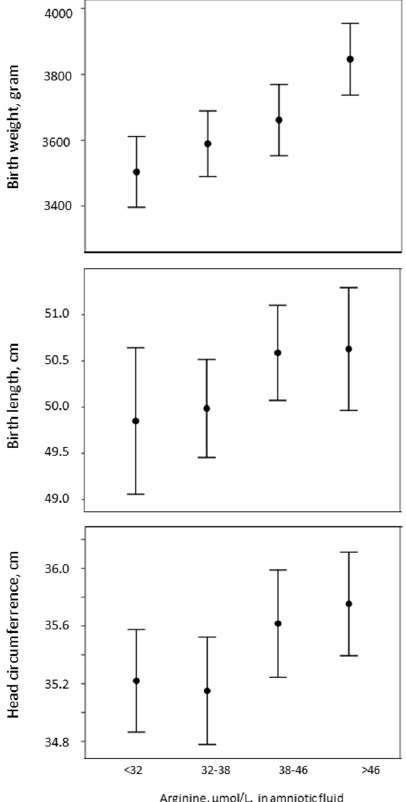
Figure 1. Changes in birth weight, length, and head circumference with respect to amniotic fluid arginine concentrations, in quartiles.